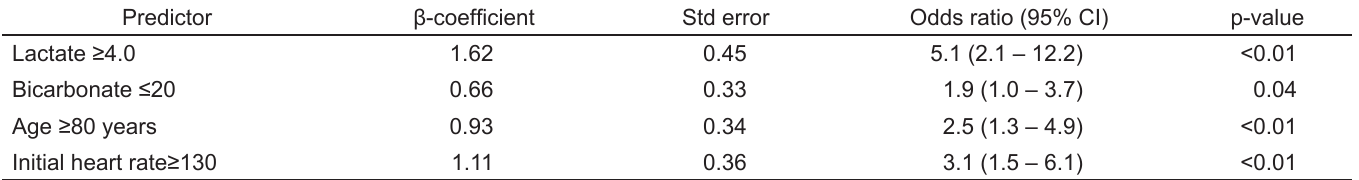
Table 4. Final multivariate logistic regression predicting deterioration after hospital admission.